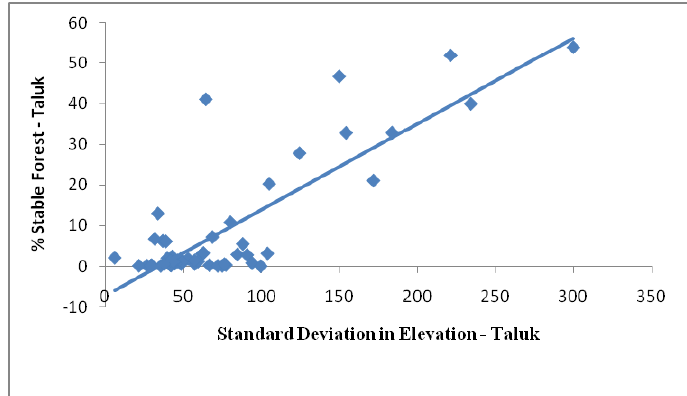
Figure 11b. Relationship between variation in elevation and the distribution of stable forest for taluks.